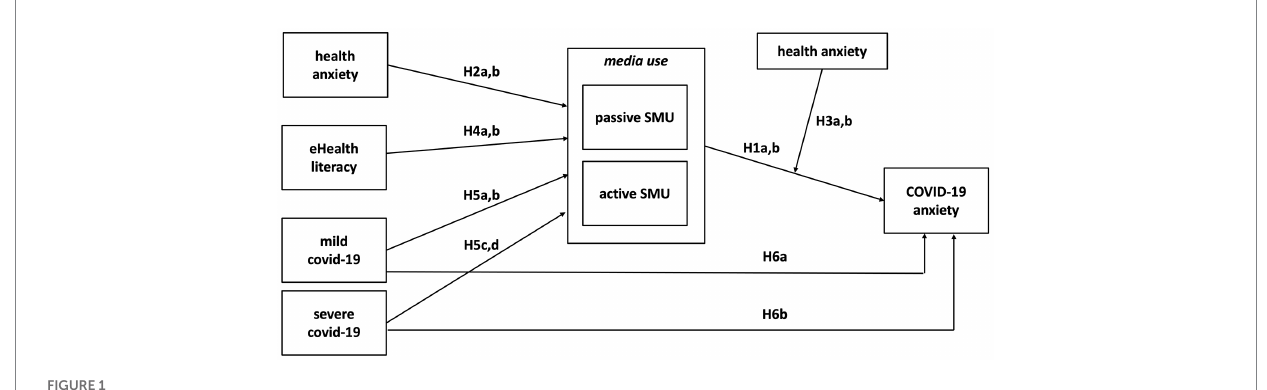
FIGURE 1 The conceptual model, with